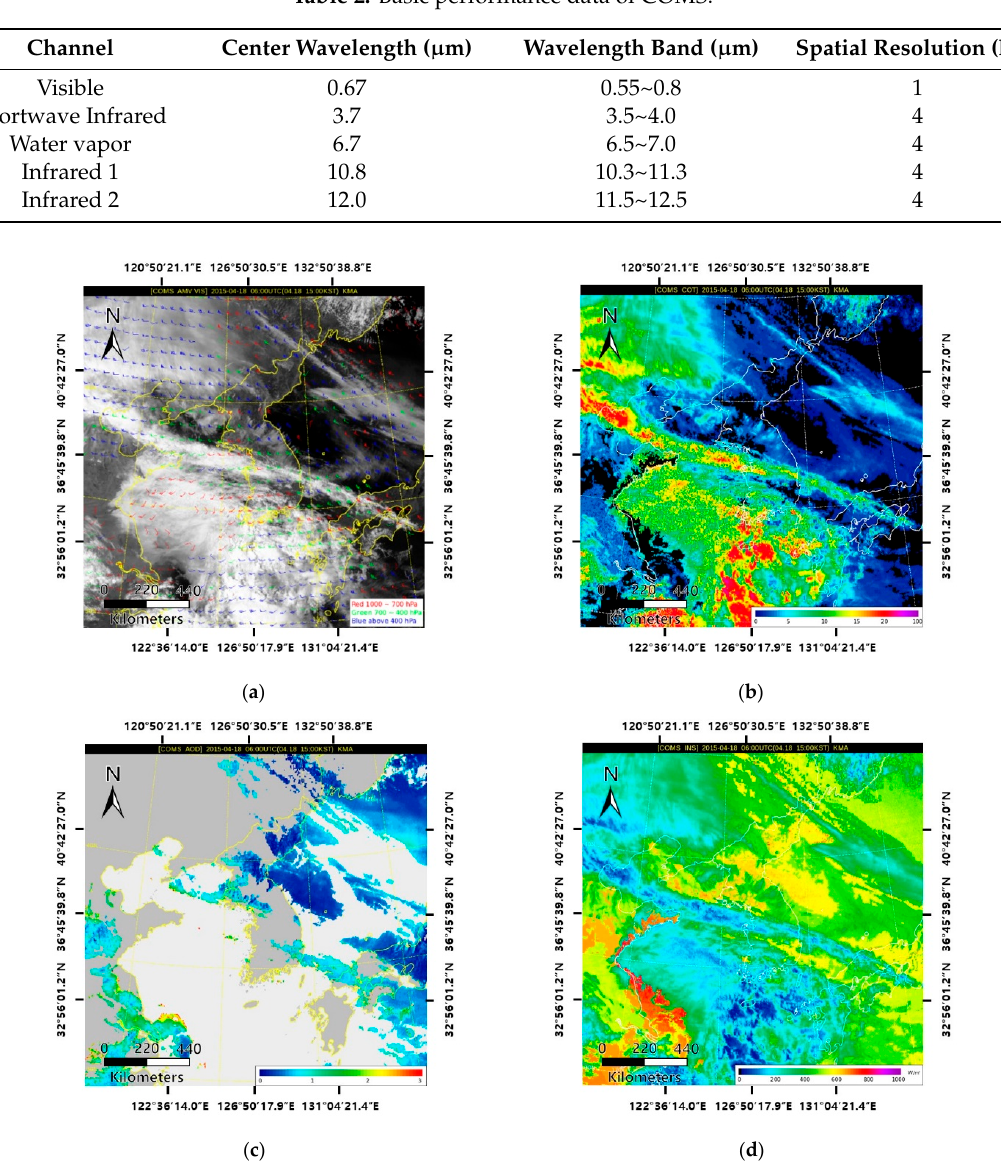
Figure 2. Four types of satellite images: ( a ) AMV Image; ( b ) Cloud Optical Thickness Image; ( c ) Aerosol Optical depth Image; ( d ) Insolation Image.